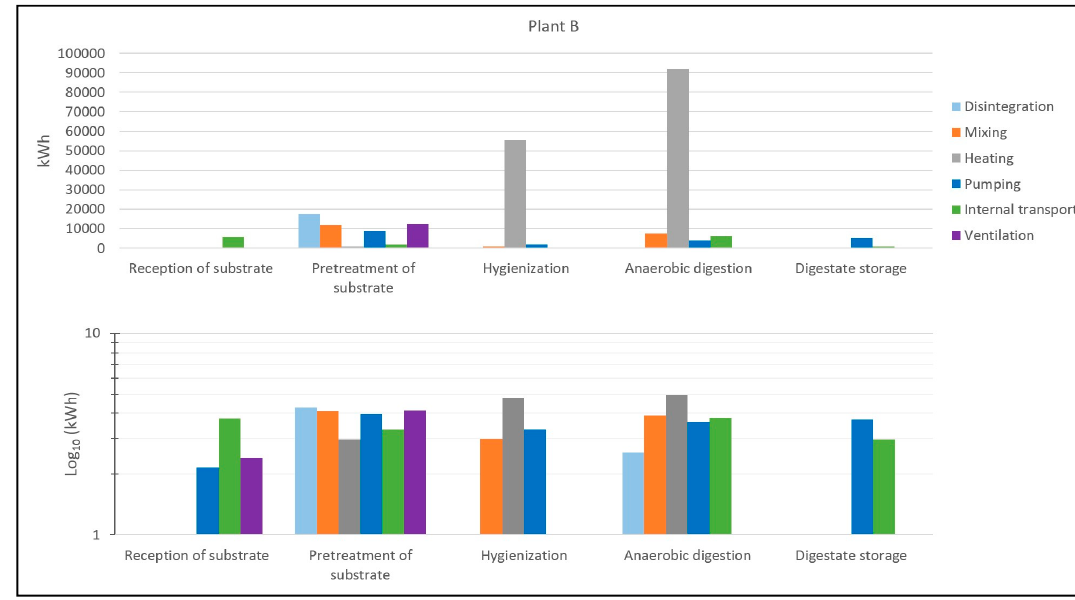
Figure 14. The total energy use for 30 days for plant A and B, presented in a combination of sub-processes and unit processes. The first two diagrams show the energy use at plant A, one with a linear scale and the other with a logarithmic scale. The last two diagrams show the energy use at plant B, one with a linear scale and the other with a logarithmic scale.